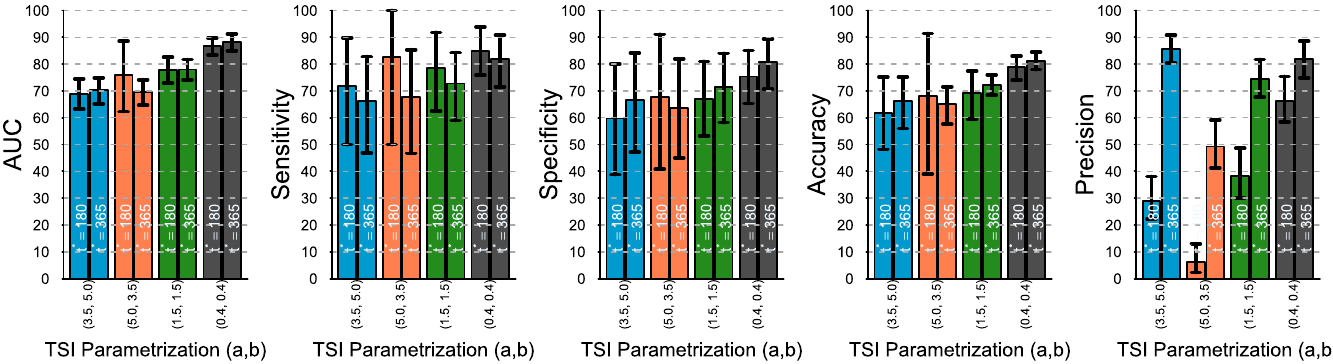
Fig 5. Comparing classification performance of the same assay with different TSI distribution and two different definitions of recency: at t * = 180 days (left bars) and t * = 365 days (right bars). With u = 0.2, sample size = 500, h = 500. The 95% prediction bounds are obtained from 1000 simulations.